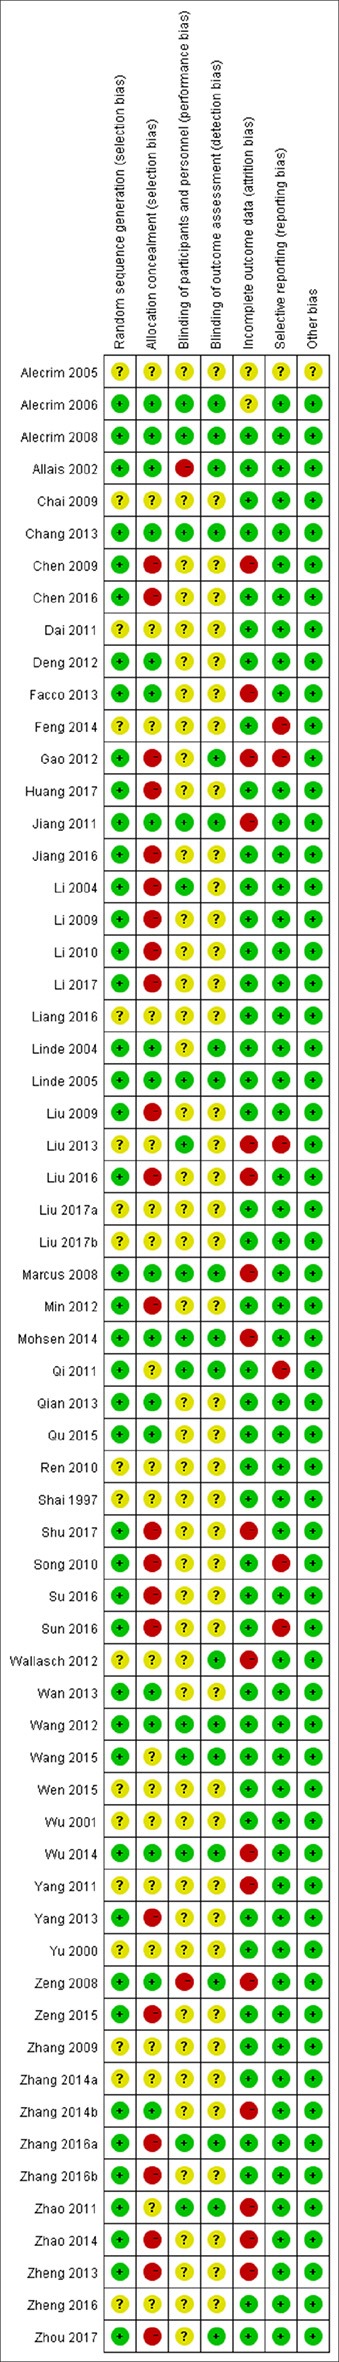
Risk of bias graph.